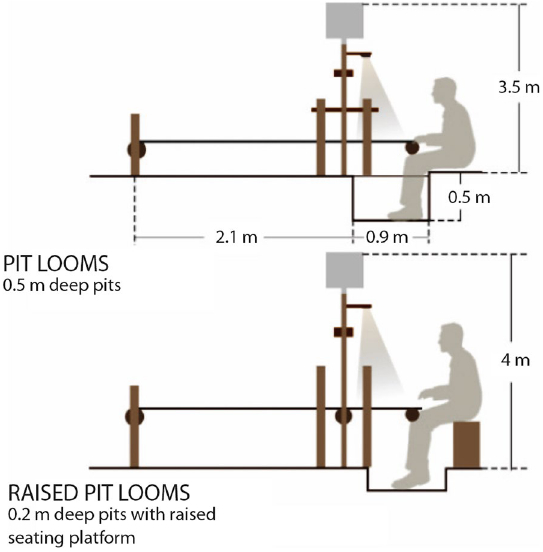
Fig. 12 Spatial requirement for pit-looms and raised pit-looms (Source: the